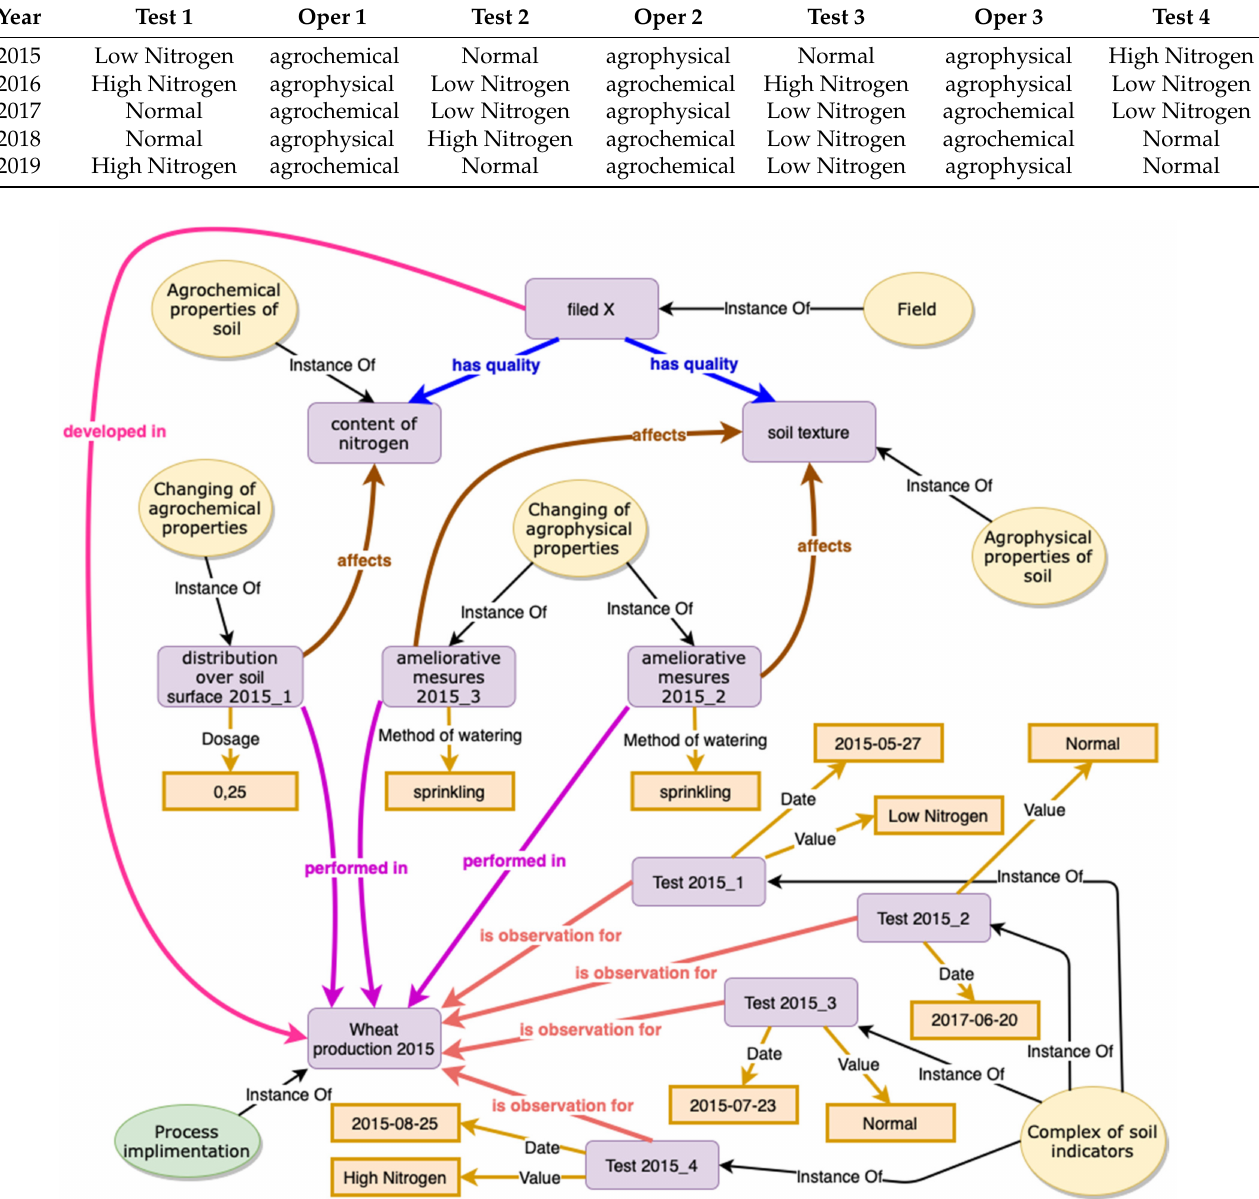
Figure 4. An example of annotated and linked domain-specific